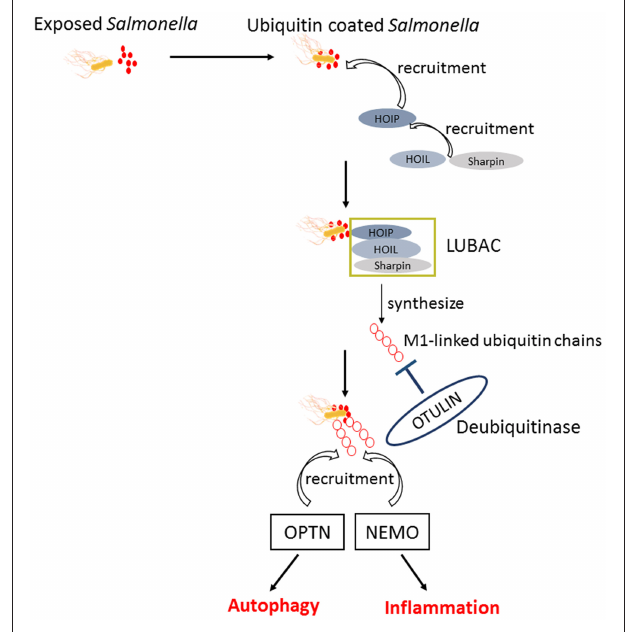
FIGURE 4 | The similar activation process of autophagy and NF- κ B pathway in response to Salmonella . Upon exposed in cytosol, Salmonellae were Ub coated and following the recruitment of HOIP, HOIL, and Sharpin. The combination of HOIP, HOIL, and Sharpin is termed as LUBAC, which can synthesize the M1-linked Ub chains. Ultimately, the M1-linked linear poly-Ub coated on Salmonellae recruit OPTN and NEMO to initiate autophagy and NF- κ B signaling pathways, which play crucial roles in restrict proliferation of Salmonellae independently. OTULIN is a DUB which inhibits the recruitment of NEMO and ultimately NF- κ B pathway by restraining the formation of M1-linked Ub